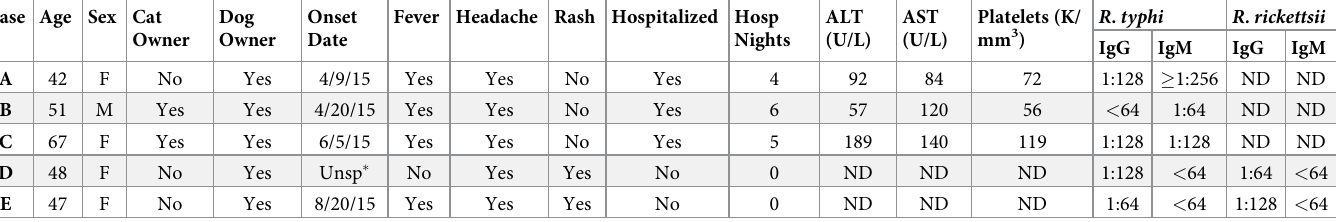
Table 1. Case characteristics of five flea-borne rickettsiosis cases residing in the investigated mobile home community in Los Angeles County, California during the outbreak period of March 1 st through August 31 st , 2015. Case Age Sex Cat